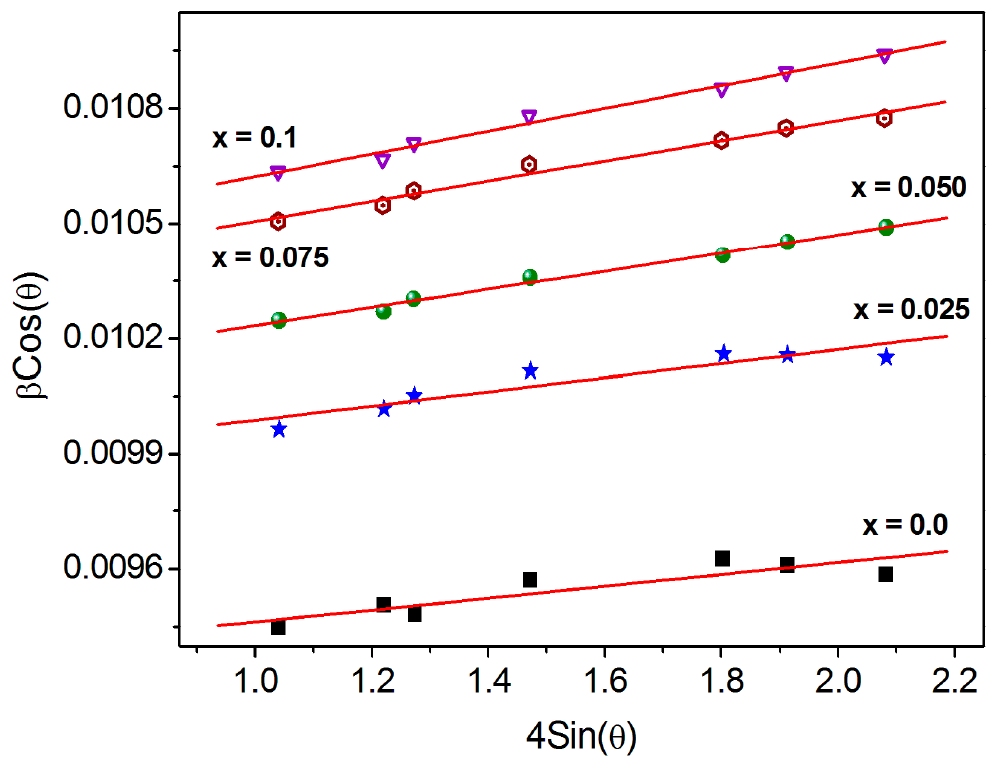
Figure 3. W-H plots of CoCr 0.5 Dy x Fe 1.5-x O 4 . Table 2. La tt ice parameter obtained from N-R function ( a 0 ), X-ray density ( ρ x-ray ), bulk density ( ρ exp ), porosity ( P ), speci fi c surface area ( S ), average crystallite size ( t xrd ), la tt ice strain ( ε ) for the series